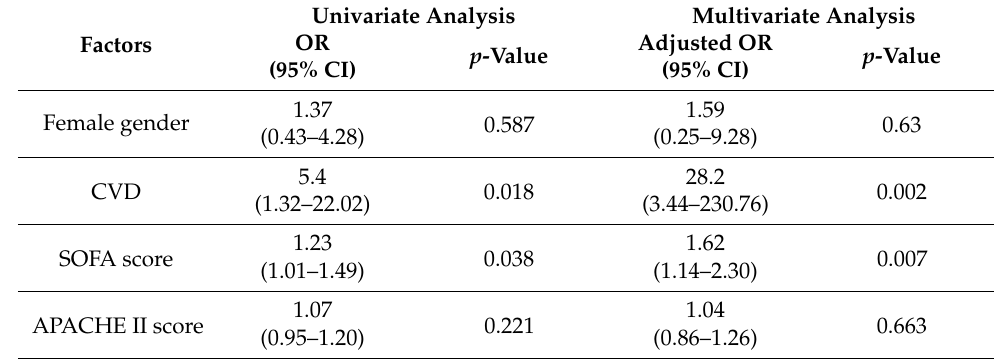
Table 4. Univariate and multivariate analysis for factors independently associated with 28-day